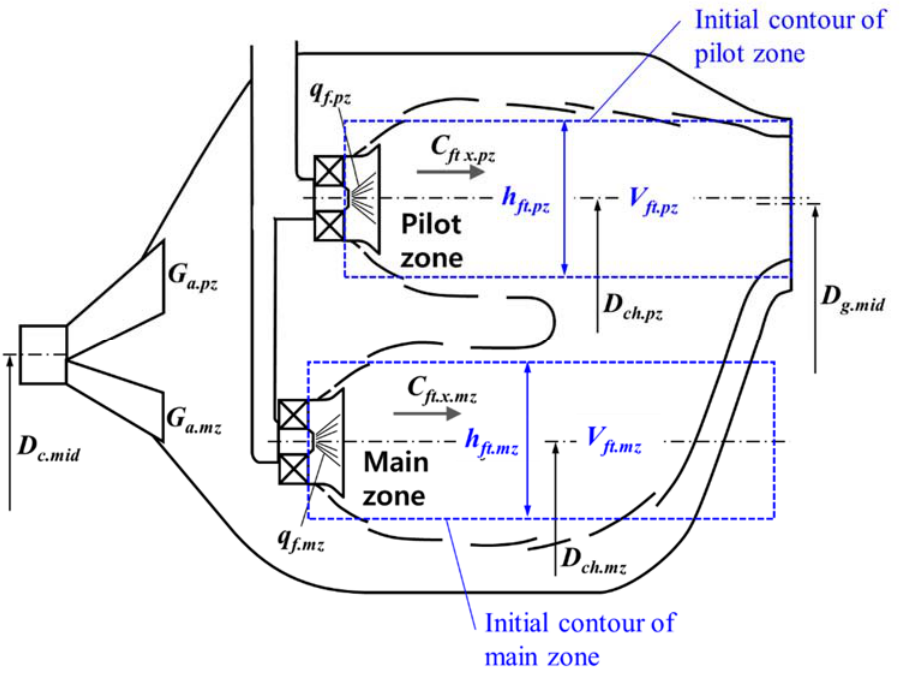
Figure 2. Schematic illustration of DAC.